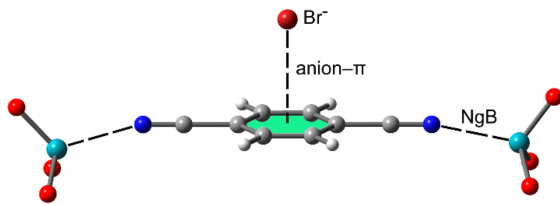
Figure 10. Four component system used by Esrafili et al. [97] to study the cooperativity e ff ect between NgBs and anion– π interactions using XeO 3 as an NgB donor and 1,4-dicyanobenzene.